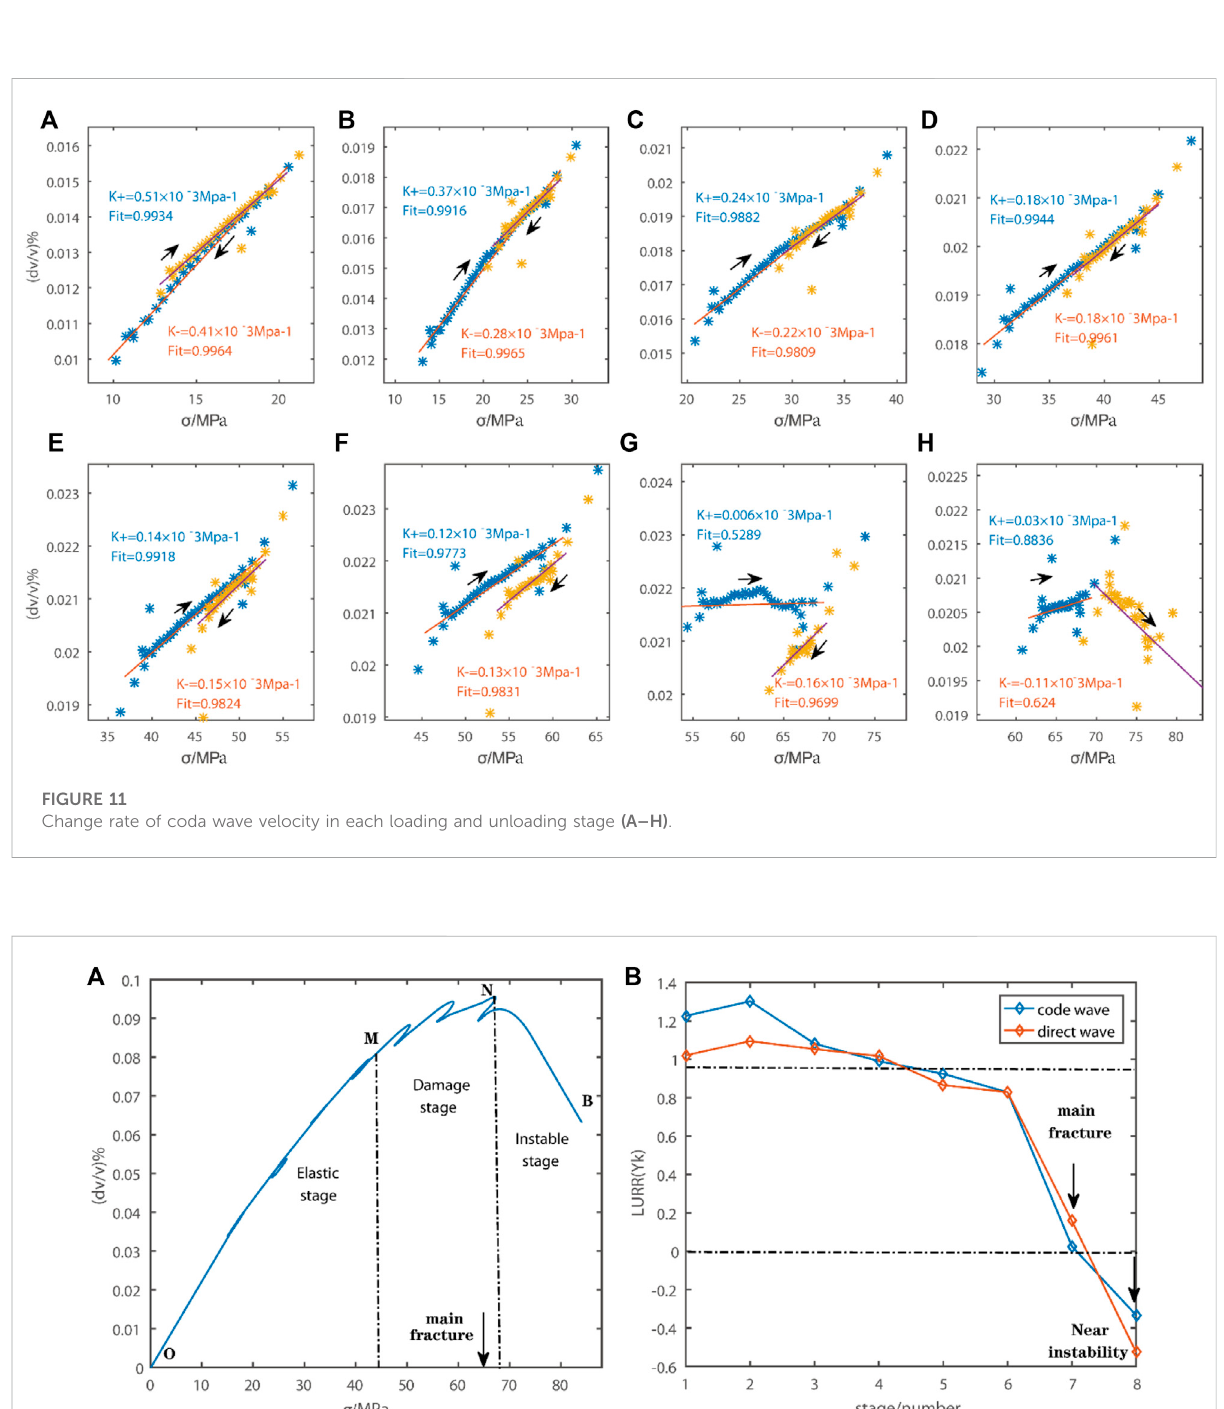
in the elastic stage, the wave velocity change and stress can keep a good linear relationship, and the accumulation and release of stress are relatively stable. In the damage stage, the relationship between stress and relative wave velocity is in a non-linear state